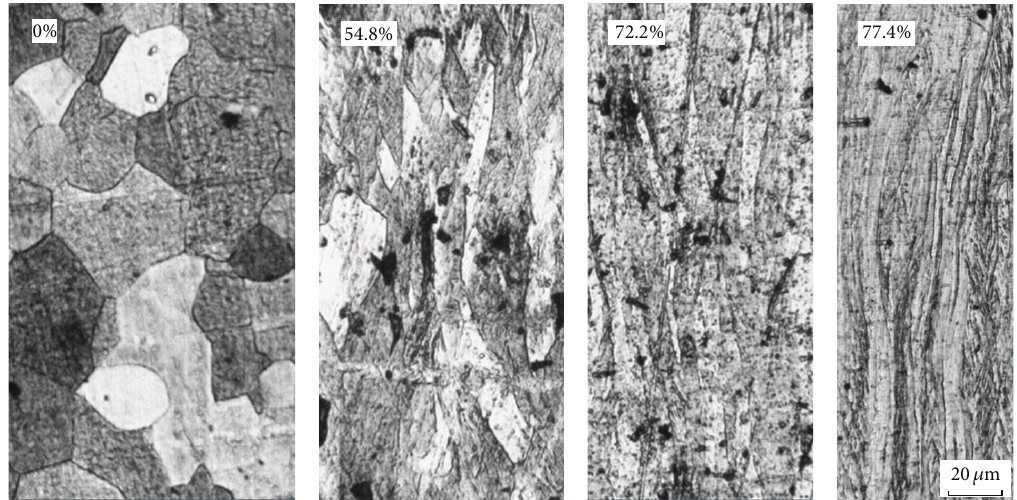
Figure 4: Microstructures of silicon steel cold rolled to different thickness reduction degrees.